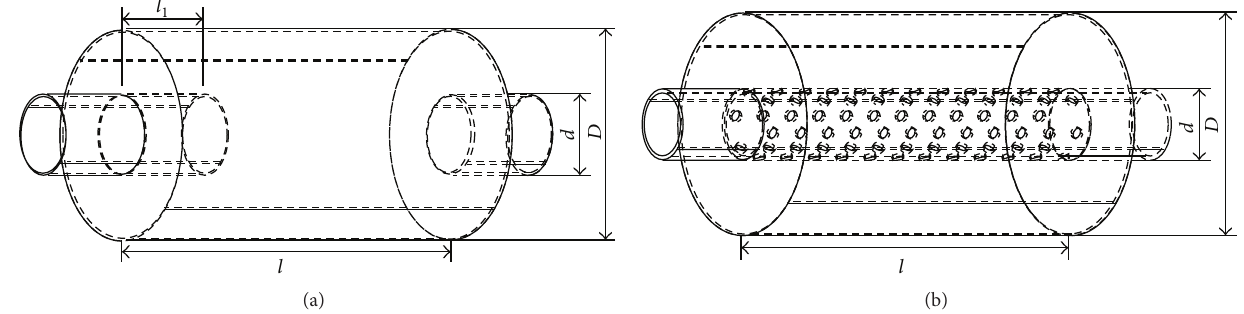
Figure 1: Geometries of the silencers considered: (a) circle expansion chamber silencer and (b) straight-through perforated pipe silencer.